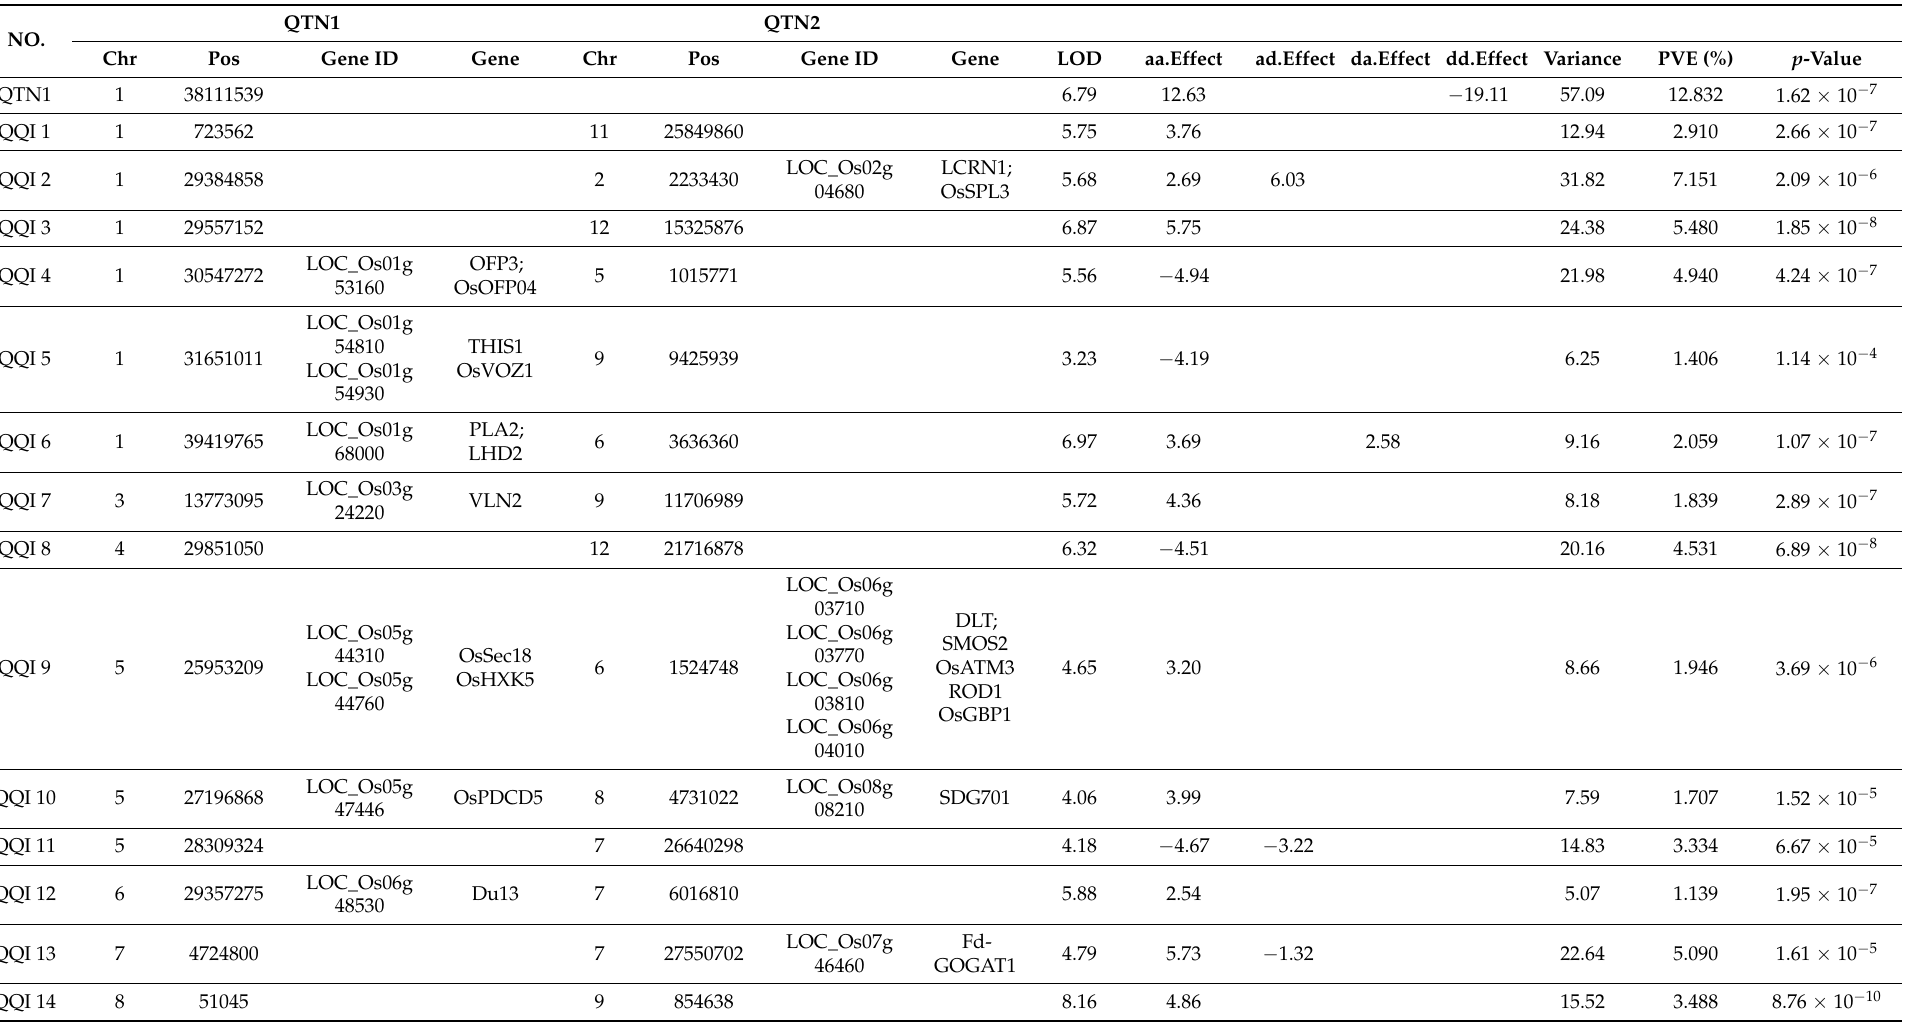
Chr: chromosome, Pos: marker’s position (bp) on the genome, variance: the variance of each QTN or QQI, PVE (%): the proportion of total phenotypic variance explained by each QTN or